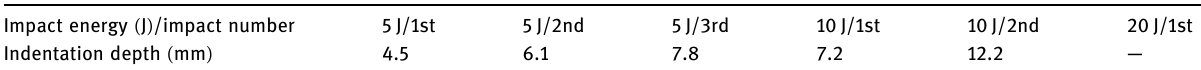
Table 2: Indentation depth for LVI